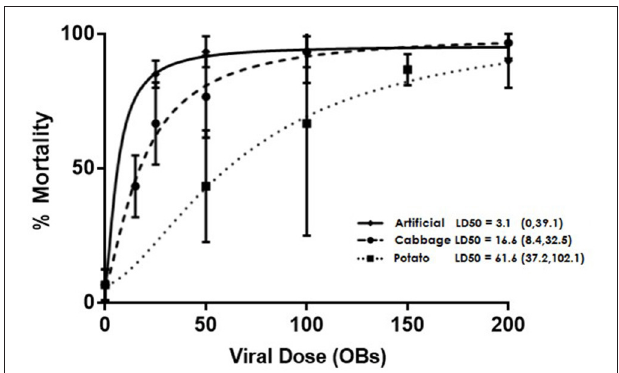
FIGURE 1 | Dose dependent mortality of AcMNPV-treated 4th instar T. ni larvae that were raised on artificial diet, cabbage, or potato. Error bars depict 95% confidence intervals.